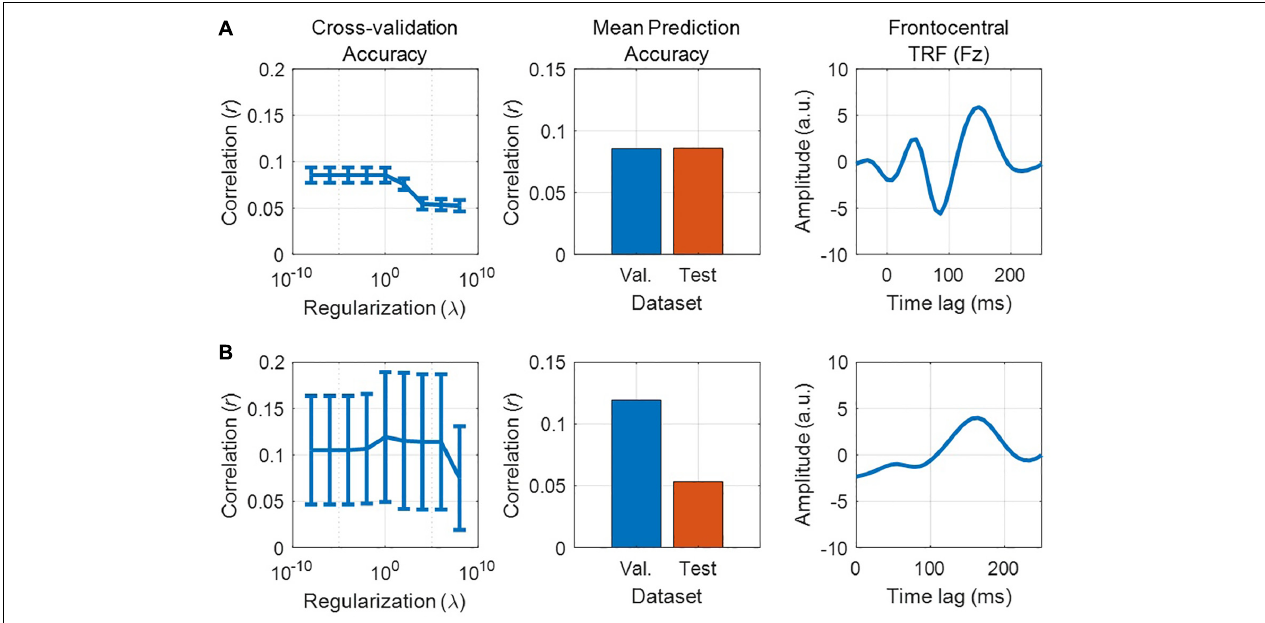
FIGURE 6 | Fitting models to small datasets. (A) Forward model (TRF) trained on 15 min of speech-EEG data using the speech envelope feature. Left, mean cross-validation accuracy (5-fold) for frontocentral channel Fz. Error bars indicate SEM across folds. Middle, mean prediction accuracy (Pearson’s r ) at Fz for validation and test sets using optimized regularization parameter. Right, optimized TRF weights at Fz. (B) Forward model trained on only 30 s of the same dataset. Left, mean cross-validation accuracy (5-fold) at Fz. Middle, mean prediction accuracy at Fz for validation and test sets using optimized regularization parameter. Right, optimized TRF weights at Fz.